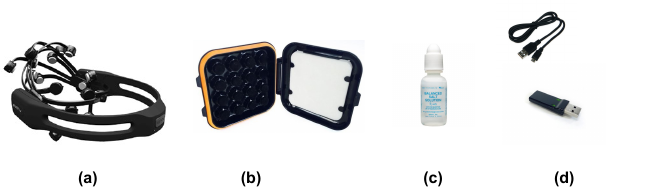
Figure 2. The different components of the Emotiv EPOC + headset: ( a ) helmet, ( b ) fourteen-sensors box, ( c ) saline solution and ( d ) USB Key with cable.